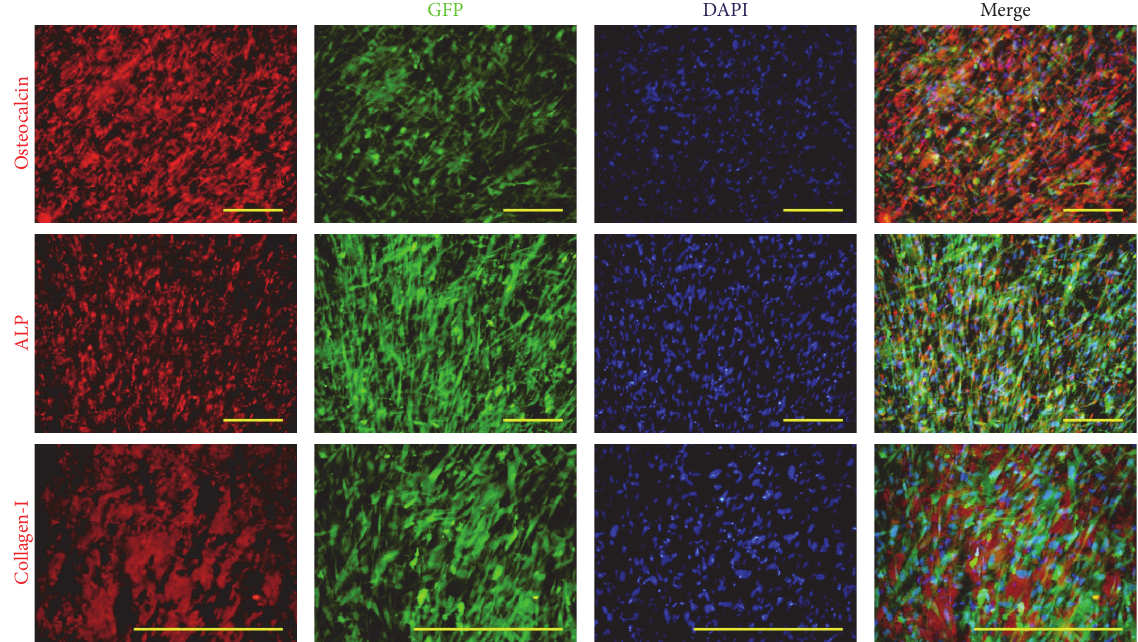
Figure 6: Osteogenic differentiation of GFP-expressing hESC-OPs demonstrated using immunocytochemical staining for osteocalcin, alkaline phosphatase (ALP), and collagen-I after 14 days of induction in osteogenic differentiation conditions. Scale bar: 500 𝜇